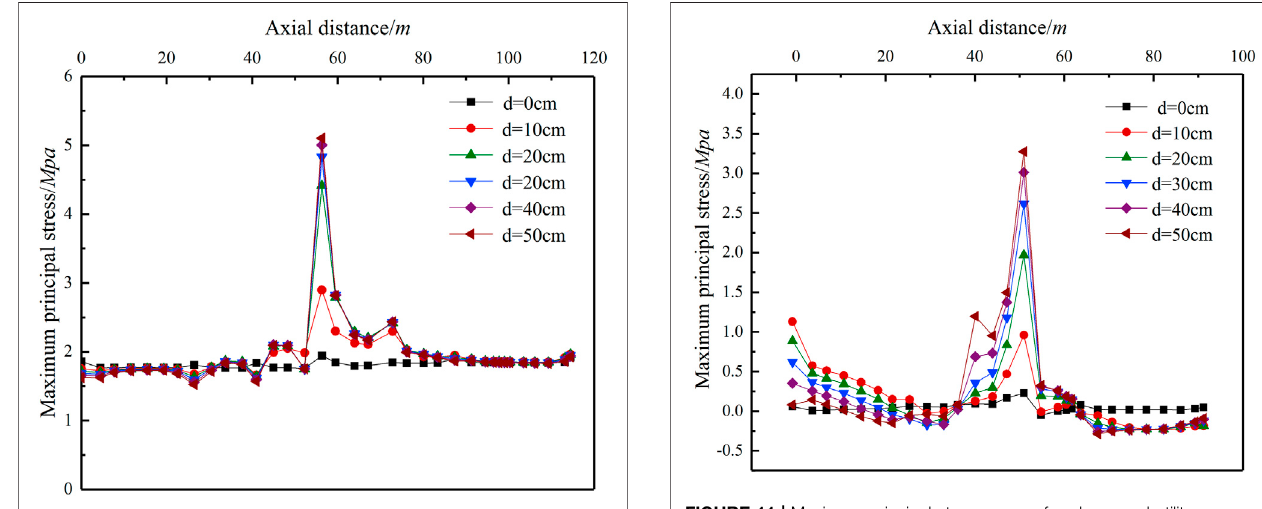
FIGURE9| Maximumprincipalstresscurveofundergroundutilitytunnel obliquely crossing the ground fi ssure (inclination 60 ° ).